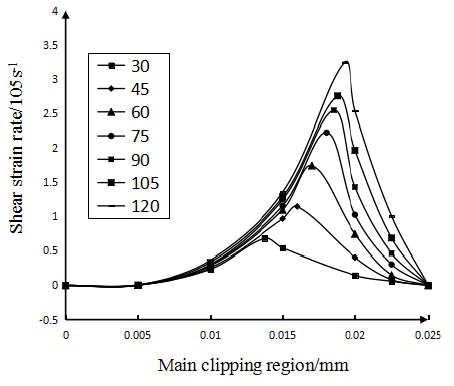
Figure 4. The influence of cutting speed on shear strain rate.